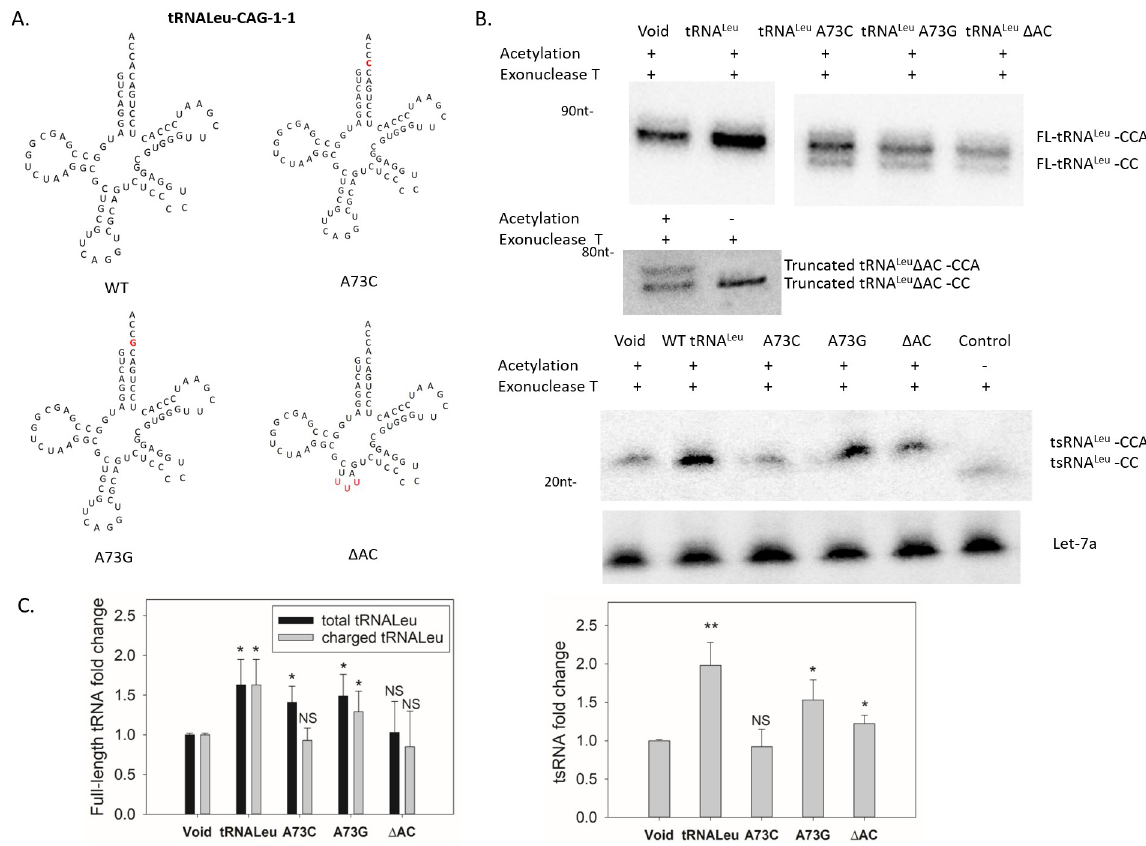
Fig 4. Overexpressions of chargeable or unchargeable tRNA Leu molecules give rise to fully charged tsRNA Leu . (A) Sequence and secondary structure of human tRNA Leu and variants. (B) Charging levels of tRNA Leu and tsRNA Leu in the HeLa cells transfected with plasmids carrying various tRNA Leu mutations. Δ AC stands for the tRNA Leu truncated variant lacking the anticodon domain. Overexpression of Δ AC variant leads to extra truncated tRNA bands around 70nt size in the northern blot as shown in the middle panel. Let-7a-3p was used as a loading control. (C) Quantification of full-length tRNA Leu , charged full-length tRNA Leu and tsRNA Leu levels when various tRNA mutants were overexpressed. Values are presented as means ± s.d. (n = 4). � , P < 0.05, �� , P < 0.01, NS, not significant, as determined by Student´s one-tailed t-test.